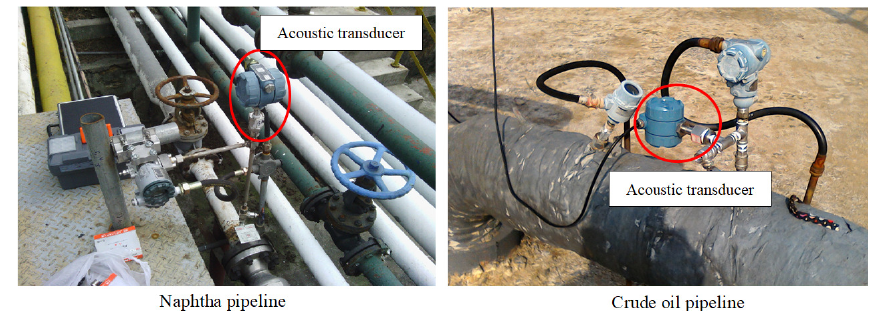
Figure 2. The configuration of the acoustic transducer.